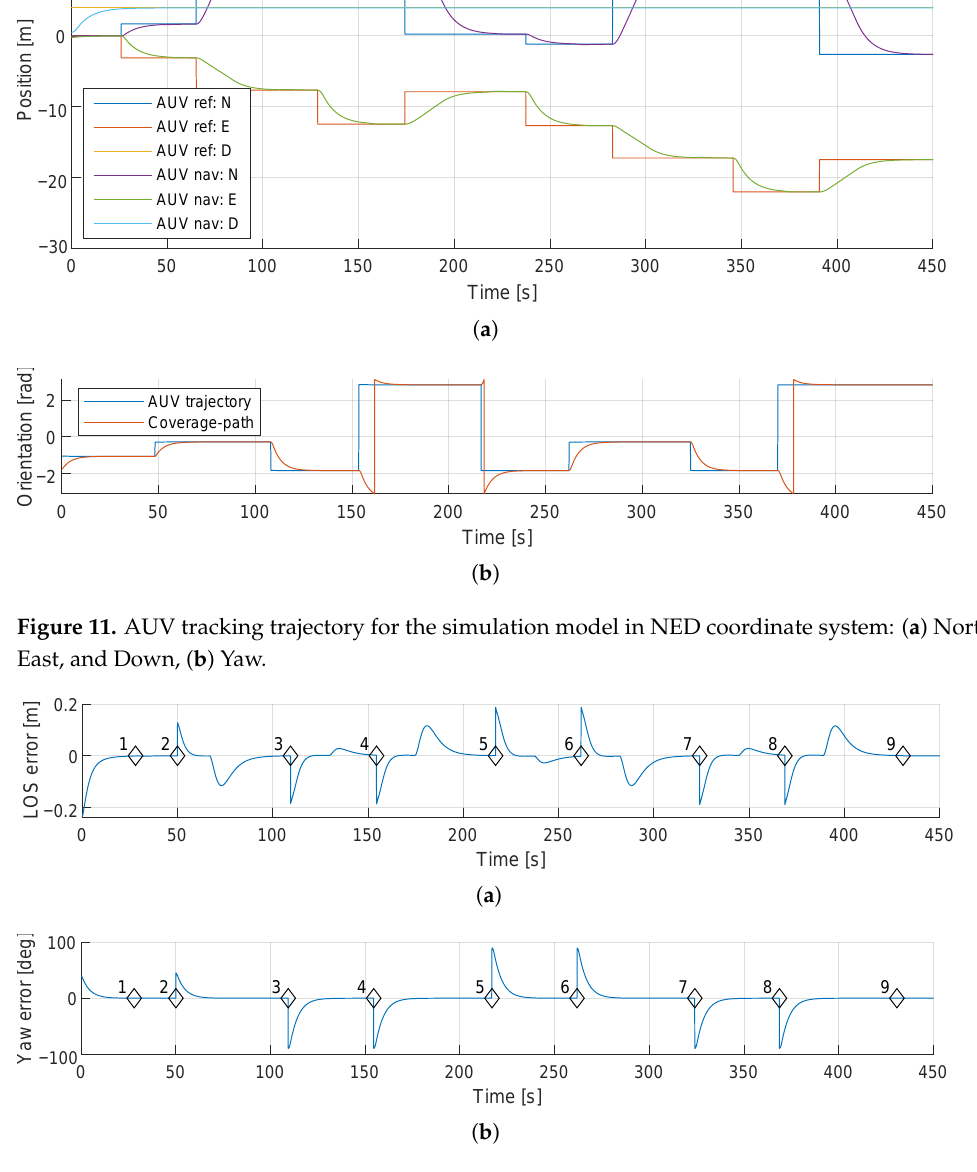
Figure 12. AUV errors at the LOS-based, path-following algorithm in Control scenario I, including the respective waypoints marked with their order number: ( a ) Cross-track error [m], ( b ) Yaw orientation error